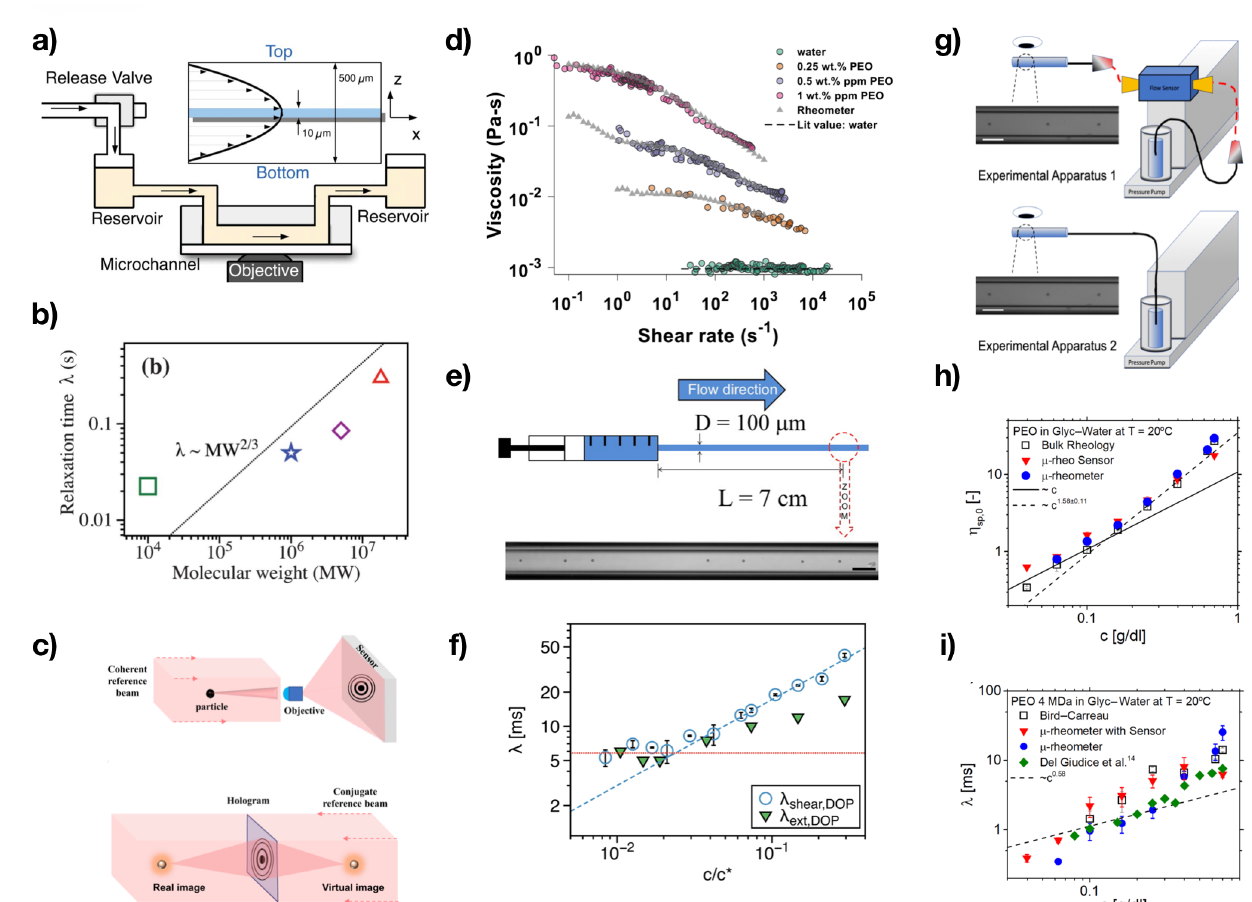
Figure 4. Examples of microfluidic rheometers based on particle tracking. ( a ) Schematic of a microflu- idic device for creep measurements, aimed at deriving the longest relaxation time λ . ( b ) Measurements of λ as a function of the polymer molecular weight for several polyacrylamide solutions, using the microfluidic rheometer in ( a ). Reprinted from Reference [56], with permission of The Royal Society of Chemistry. ( c ) Schematic of the microfluidic rheometer based on digital holography microscopy. ( d ) Good agreement between microfluidic and conventional rheometry data for several PEO solutions. Reprinted with permission from Gupta and Vanapalli [58], with the permission of AIP publishing. ( e ) Schematic of the µ -Rheometer microfluidic rheometer, based on the transversal migration of rigid particles flowing in microchannels. ( f ) Good agreement between the µ -rheometer and the OSCER [69] was found for polystyrene solution in dioctyl phthalate. Reprinted from Del Giudice et al. [64]. ( g ) Schematic of the µ -rheometer for the simultaneous measurement of zero-shear viscosity and longest relaxation time. ( h ) Good agreement was observed between microfluidic and bulk zero-shear viscosity data for several PEO solutions. ( i ) Good agreement was observed between microfluidic and bulk longest relaxation time data for several PEO solutions. Reprinted from Del Giudice